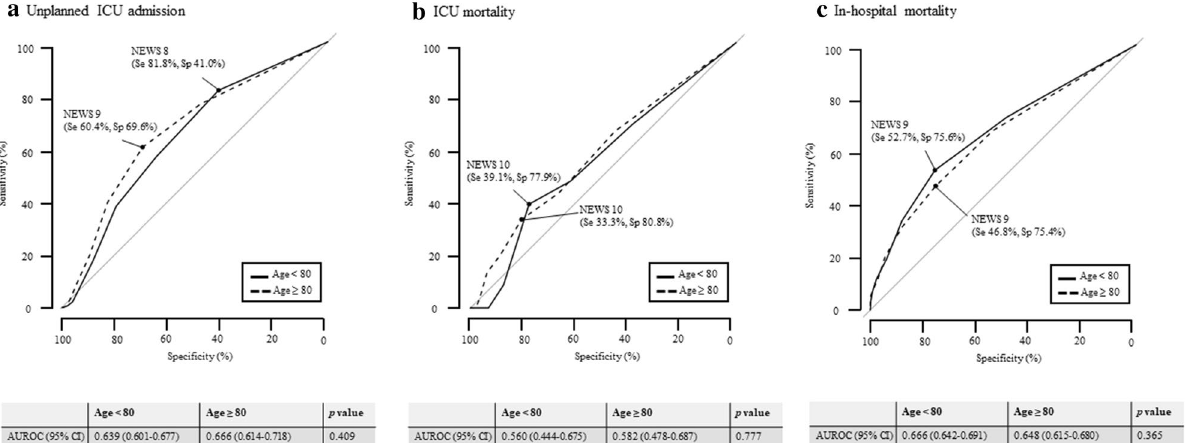
Figure 1. Receiver operating characteristic curves of the National early warning score for severe outcomes by age group. Dots indicate thresholds of National early warning score for the highest accuracy. NEWS National early warning score, ICU intensive care unit, AUROC area under the receiver operating characteristic curve, Se sensitivity, Sp specificity.